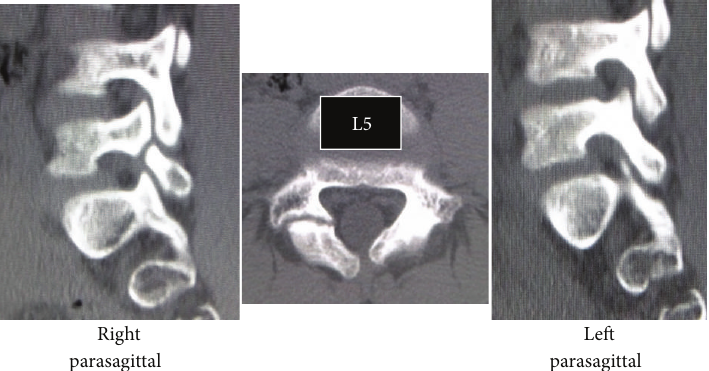
Figure 6: CT of Case 2. The right side unilateral L5 spondylolysis is considered to be at the terminal stage.